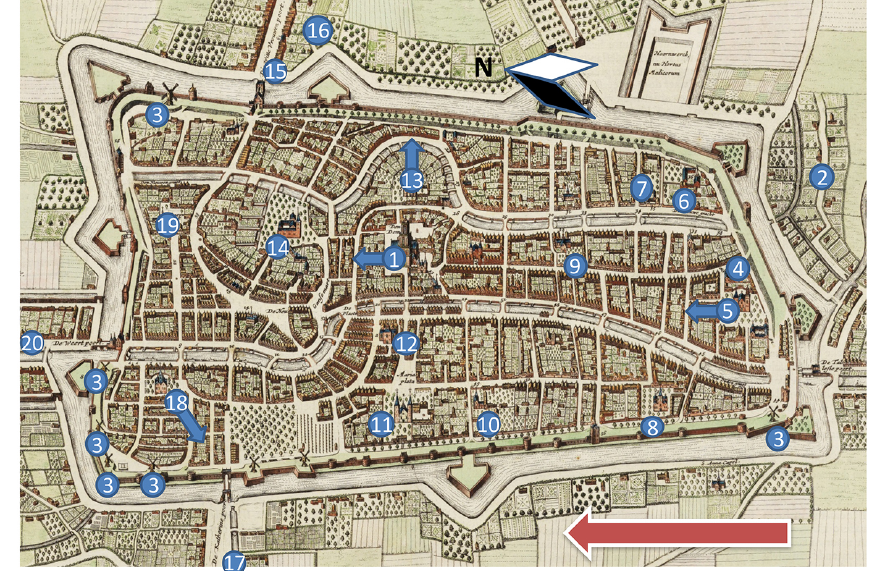
Figure 6. Compiled damages to larger structure in the city of Utrecht. The numbers in blue circles refer to Table 1; blue arrows refer to the direction in which the structure collapsed (details in Sect. 3.2). The large red arrow denotes the direction in which the front moved over Utrecht. Map from J. Bleau (1649), Utrecht City Archive no. 214022.